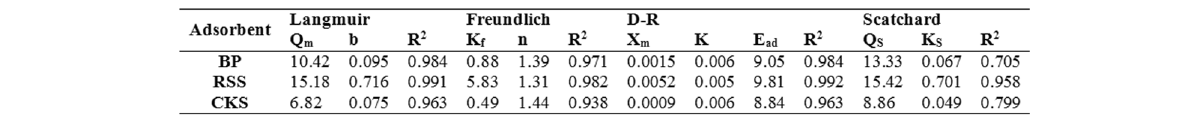
Table 1 Parameters of Langmuir, Freundlich, Scatchard, and D-R isotherms for adsorption of Cr(VI) on 252 BP, RSS, and